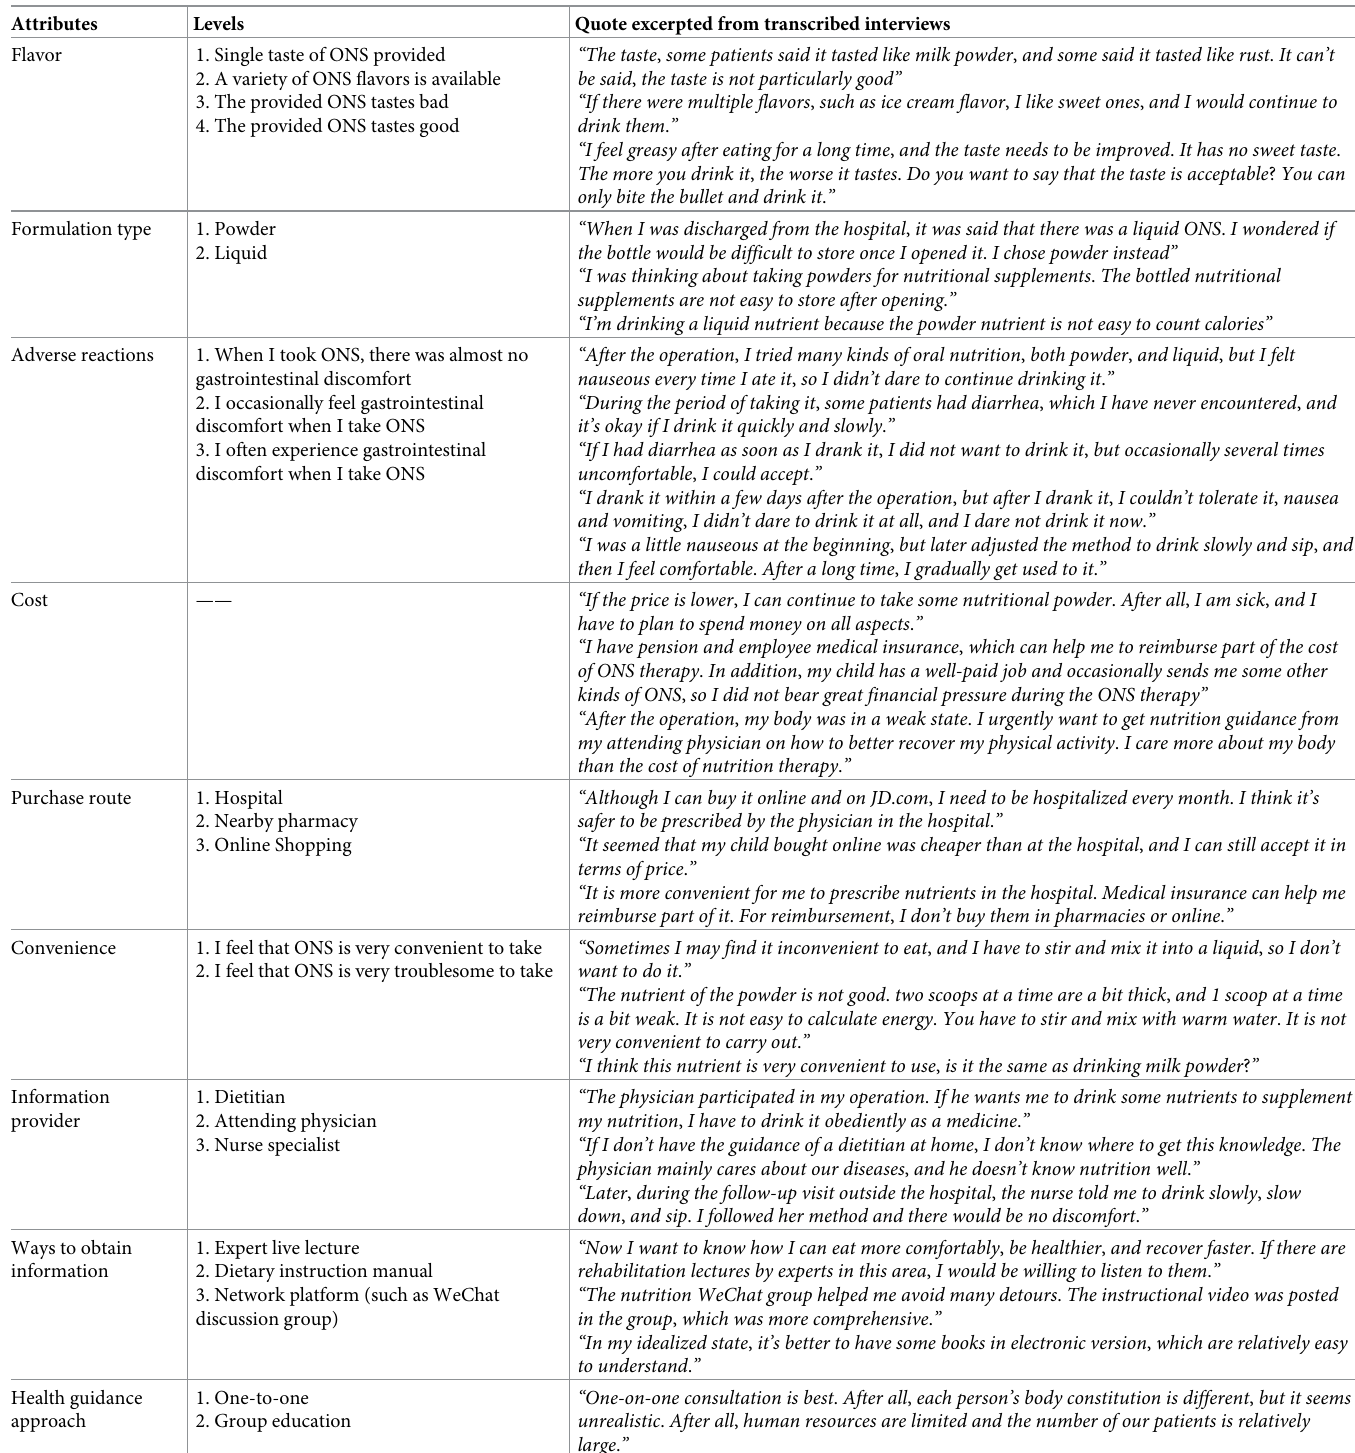
Table 4. Included attributes and levels from in-depth